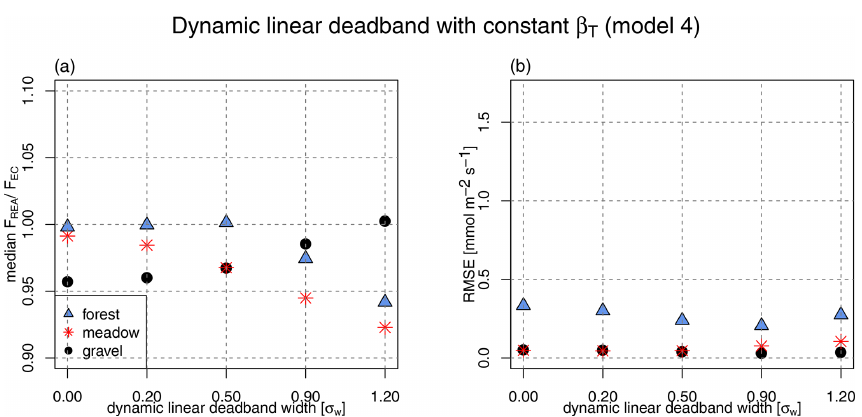
Figure 8. Errors as a function of dynamic linear deadband width. The x axis is the scaling factor a multiplied by the vertical wind standard deviation σ w in Eq. (9) to define the deadband threshold. (a) Median F REA /F EC ratio (latent heat flux simulated using constant β T, const and dynamic linear vertical wind deadband) for each of the simulated dynamic deadband widths; (b) RMSE for each of the simulated dynamic deadband widths. Table 2. Median β parameters for the chosen optimum deadband sizes for each of the four models and each of the three sites. Model β , deadband Meadow Gravel Forest Model 1 β T , linear deadband width σ w = 0 . 5 0.38 0.39 0.42 Model 2 β T , hyperbolic deadband width H = 0 . 5 0.25 0.26 0.27 Model 3 β w , linear deadband width σ w = 0 . 5 0.43 Model 4 β T, const , linear deadband width σ w = 0 .